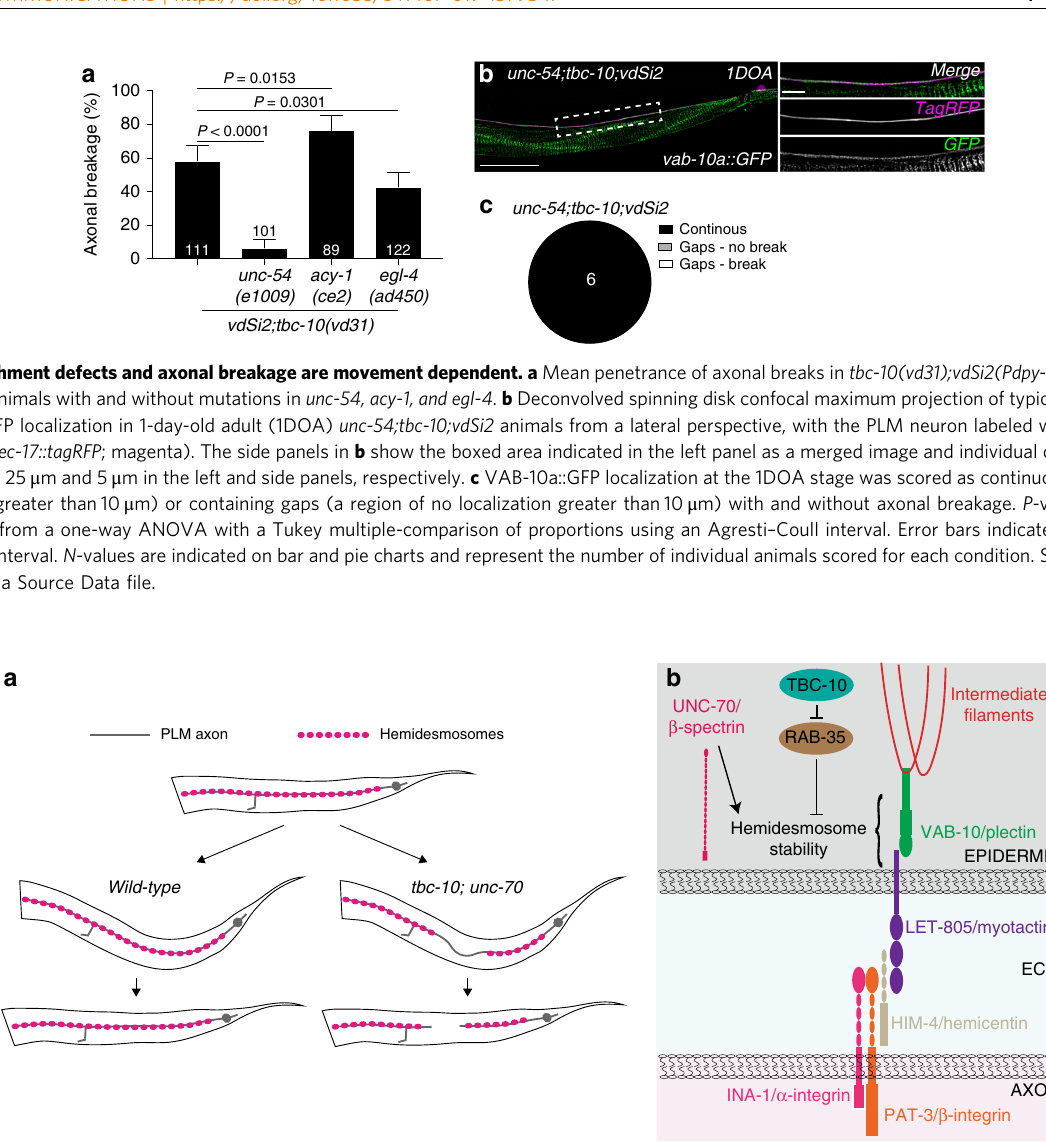
Supplementary Tables 1 and 2. The morphology marker uIs115(Pmec-17::tagRFP)]